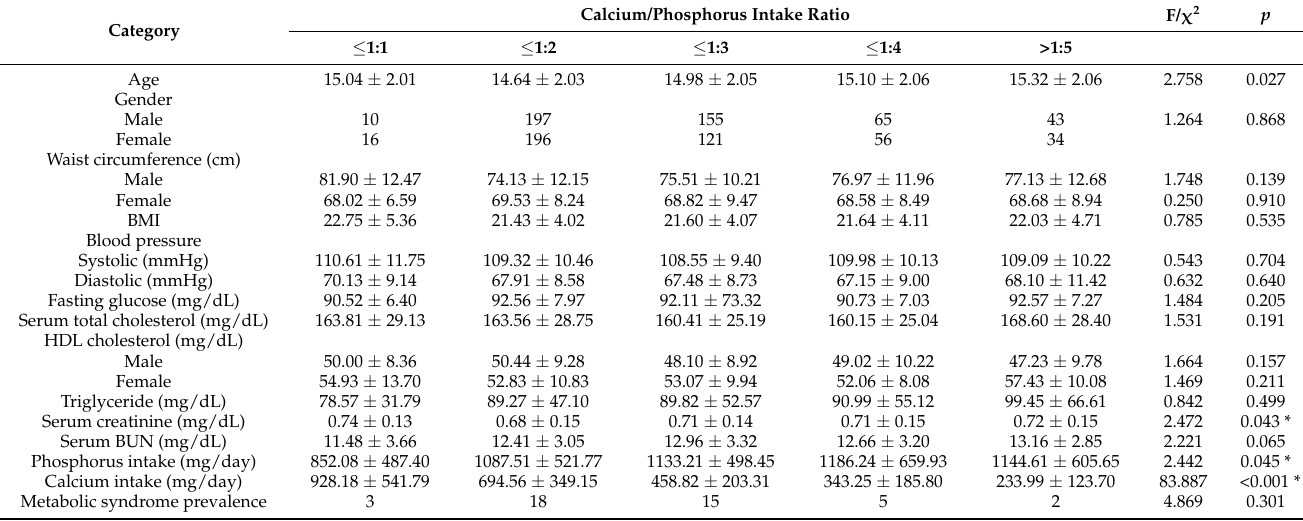
Table 2. Comparison of General Characteristics among the Calcium/Phosphorus intake ratio (N = 893). Category